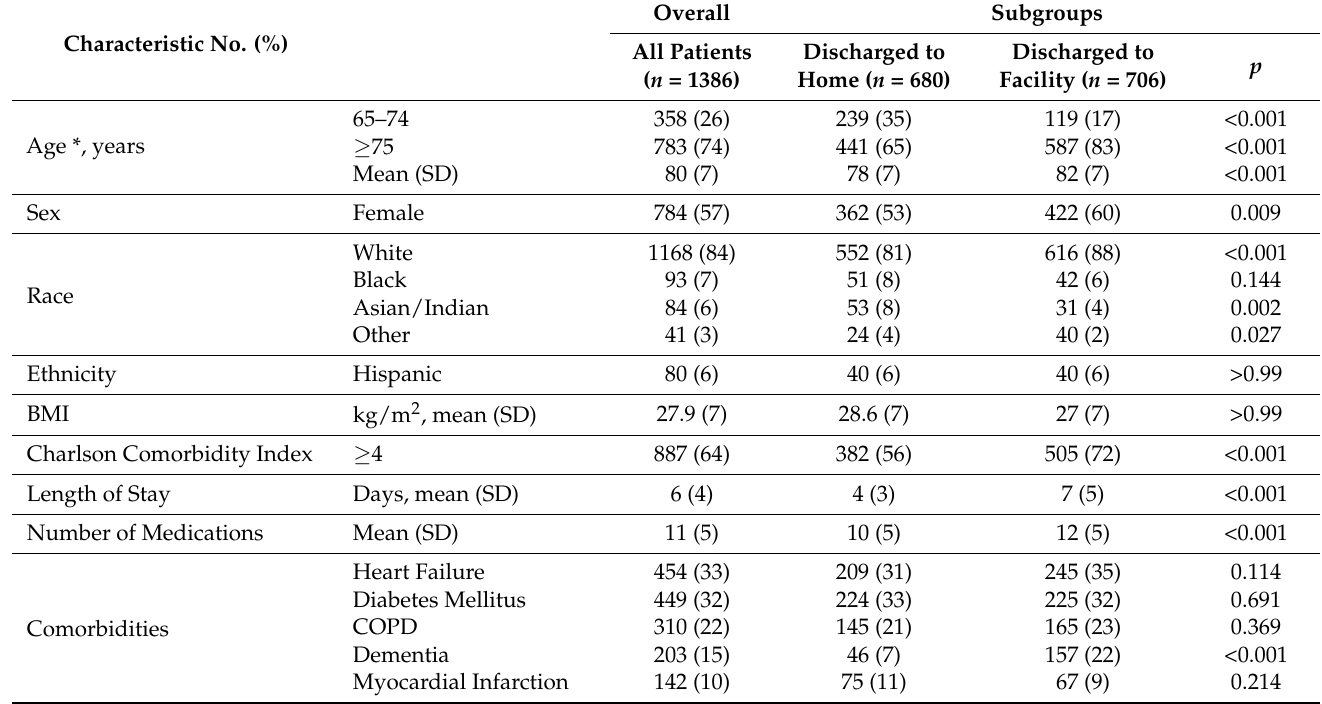
Table 1. Clinical characteristics of all patients and subgroups.